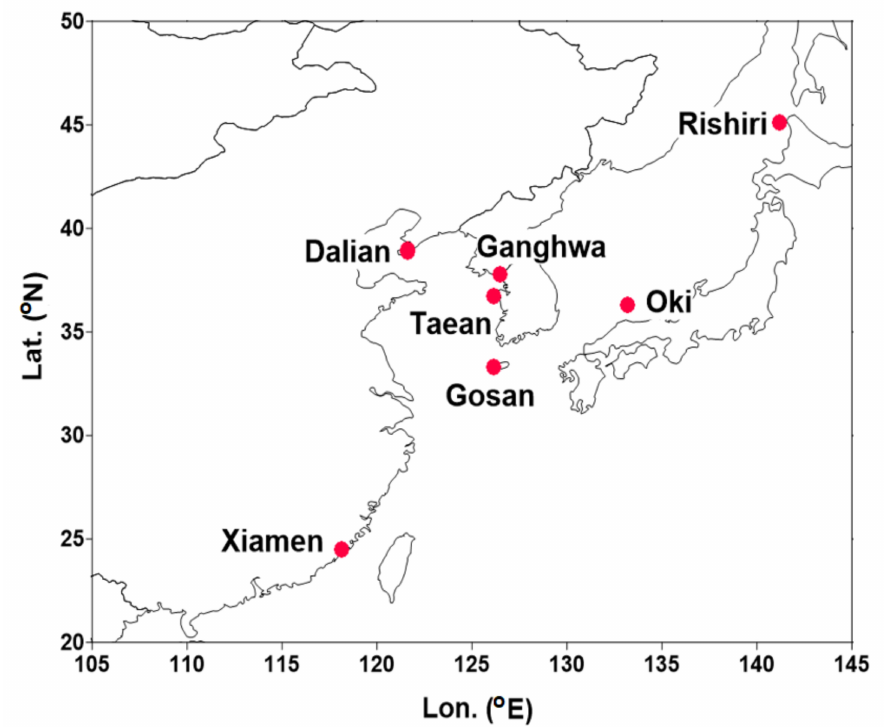
Figure 1. Locations of seven monitoring sites representing exit-and-entrance areas of transboundary transport over China, Japan, and Korea. The longitudes and latitudes of the seven sites are presented in Supplementary Table